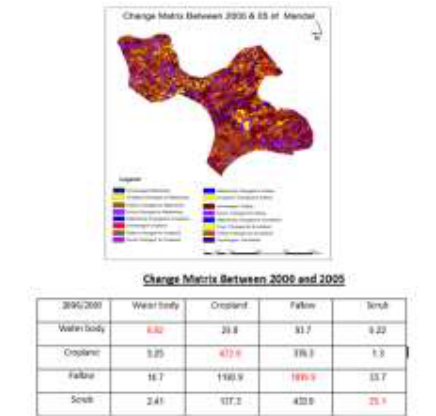
Figure-5- Change Matrix between 2000 to 2005